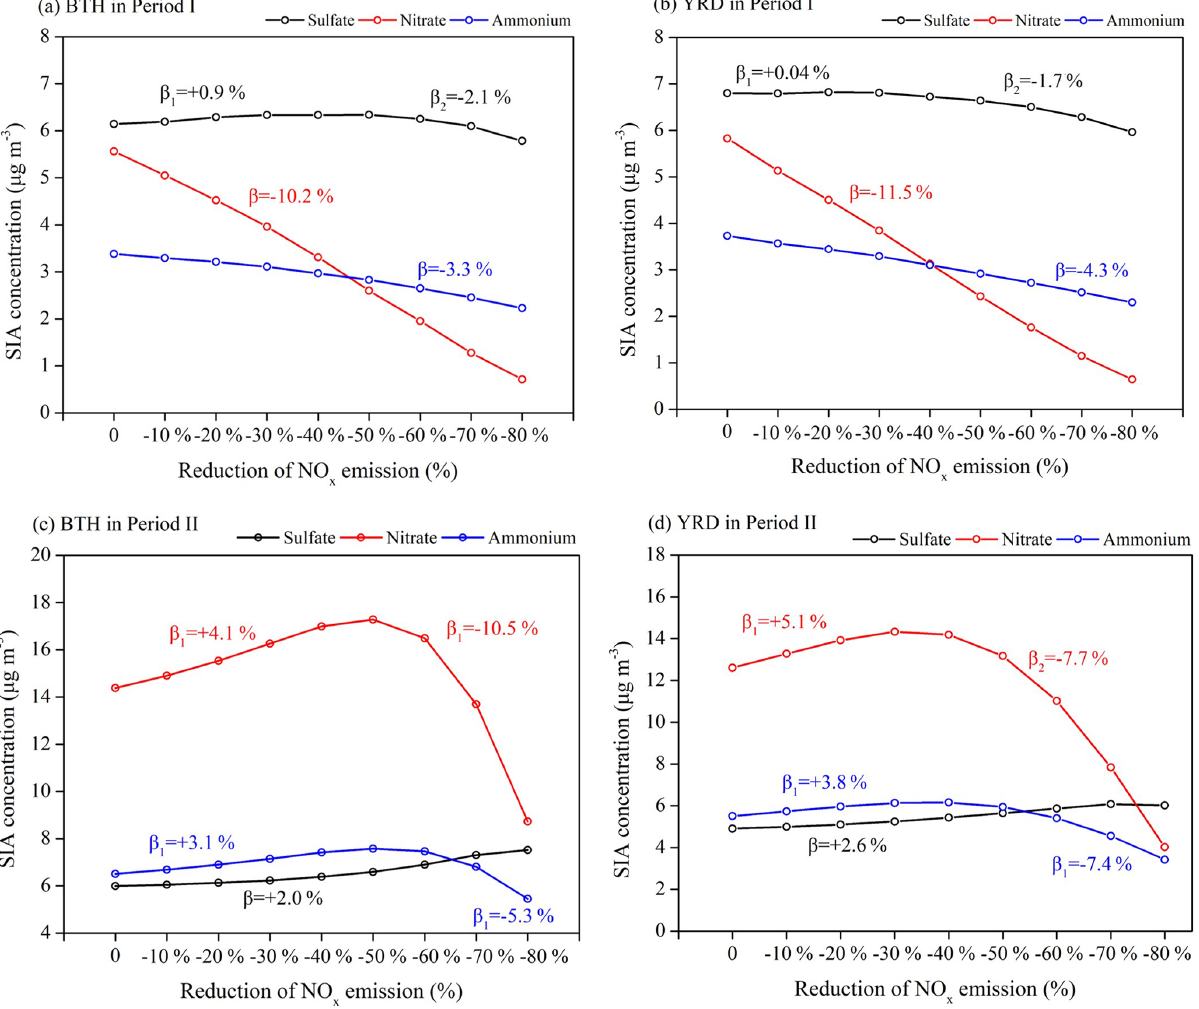
Figure 10. Responses of the surface concentrations of SIA components to the NO x emission reduction scenarios and their emission control efficiencies in (a,b) Period I and (c,d) Period